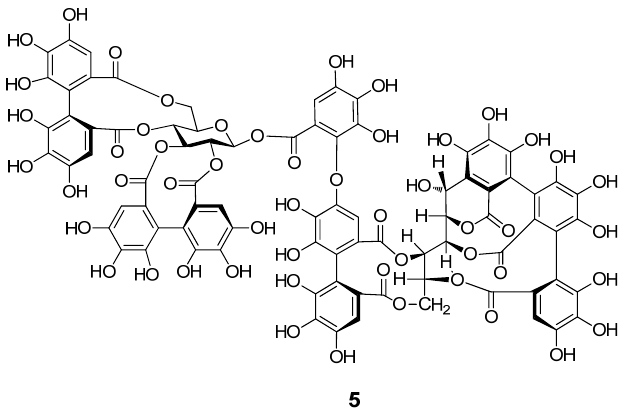
Figure 3. Structure of cocciferin D 2 ( 5 ).